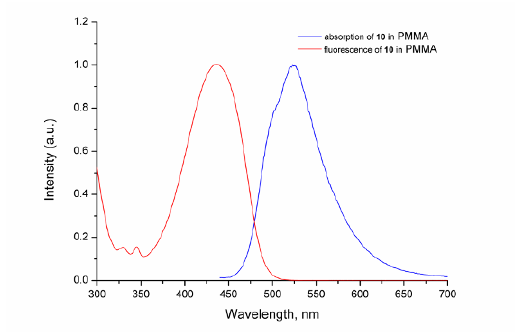
Figure 3. Absorbance and fluorescence spectra of compound 5 deposited in PMMA film.